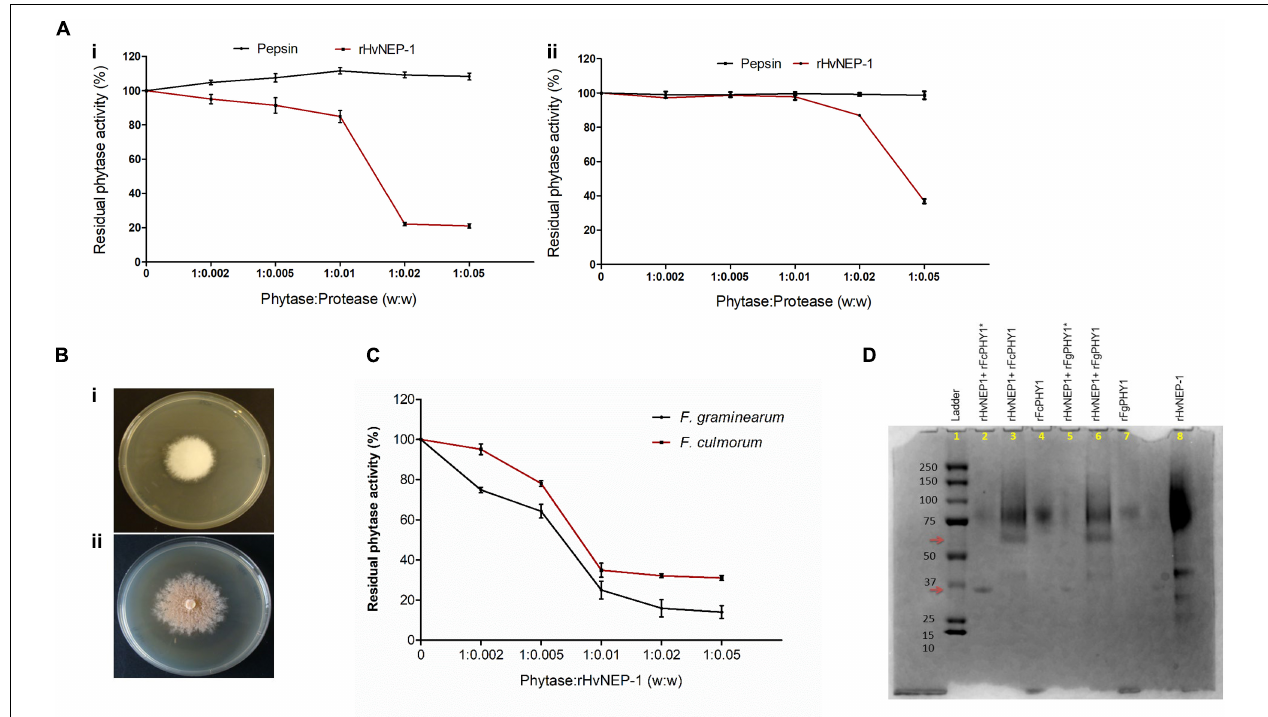
FIGURE 4 | Effects of rHvNEP-1 on the activity of fungal and plant phytases. (A) Residual activity of the A. ficuum (i) and TaPAPhy (ii) phytases after incubation with rHvNEP-1 or pepsin under different phytase/protease ratio (w:w). (B) Screening of phytase-producing strains of Fusarium graminearum 7775 (i) and Fusarium culmorum 8984 (ii) on agar plates containing sodium phytate substrate, pH 6.5. (C) Activity of crude F. graminearum and F. culmorum phytases with increasing concentrations of rHvNEP-1 (w:w). Values in (A,C) are the mean of three independent technical replicates. Error bars = mean ± SE ( n = 3). (D) SDS–PAGE analysis of rFgPHY1 and rFcPHY1 degradation by rHvNEP-1 at pH 5.0. The protein ladder indicated in lane 1. rFgPHY1 or rFcPHY1 incubated for 1 h (i.e., without asterisk, lane 3 and 6) and 24 h (i.e., with asterisk, lane 2 and 5). Lane 4, 7, and 8 stand for rFcPHY1, rFgPHY1, and rHvNEP-1, respectively. The upper and lower red arrows indicate the degradation product of rFgPHY1 and rFcPHY1 after incubated with rHvNEP-1 for 1 and 24